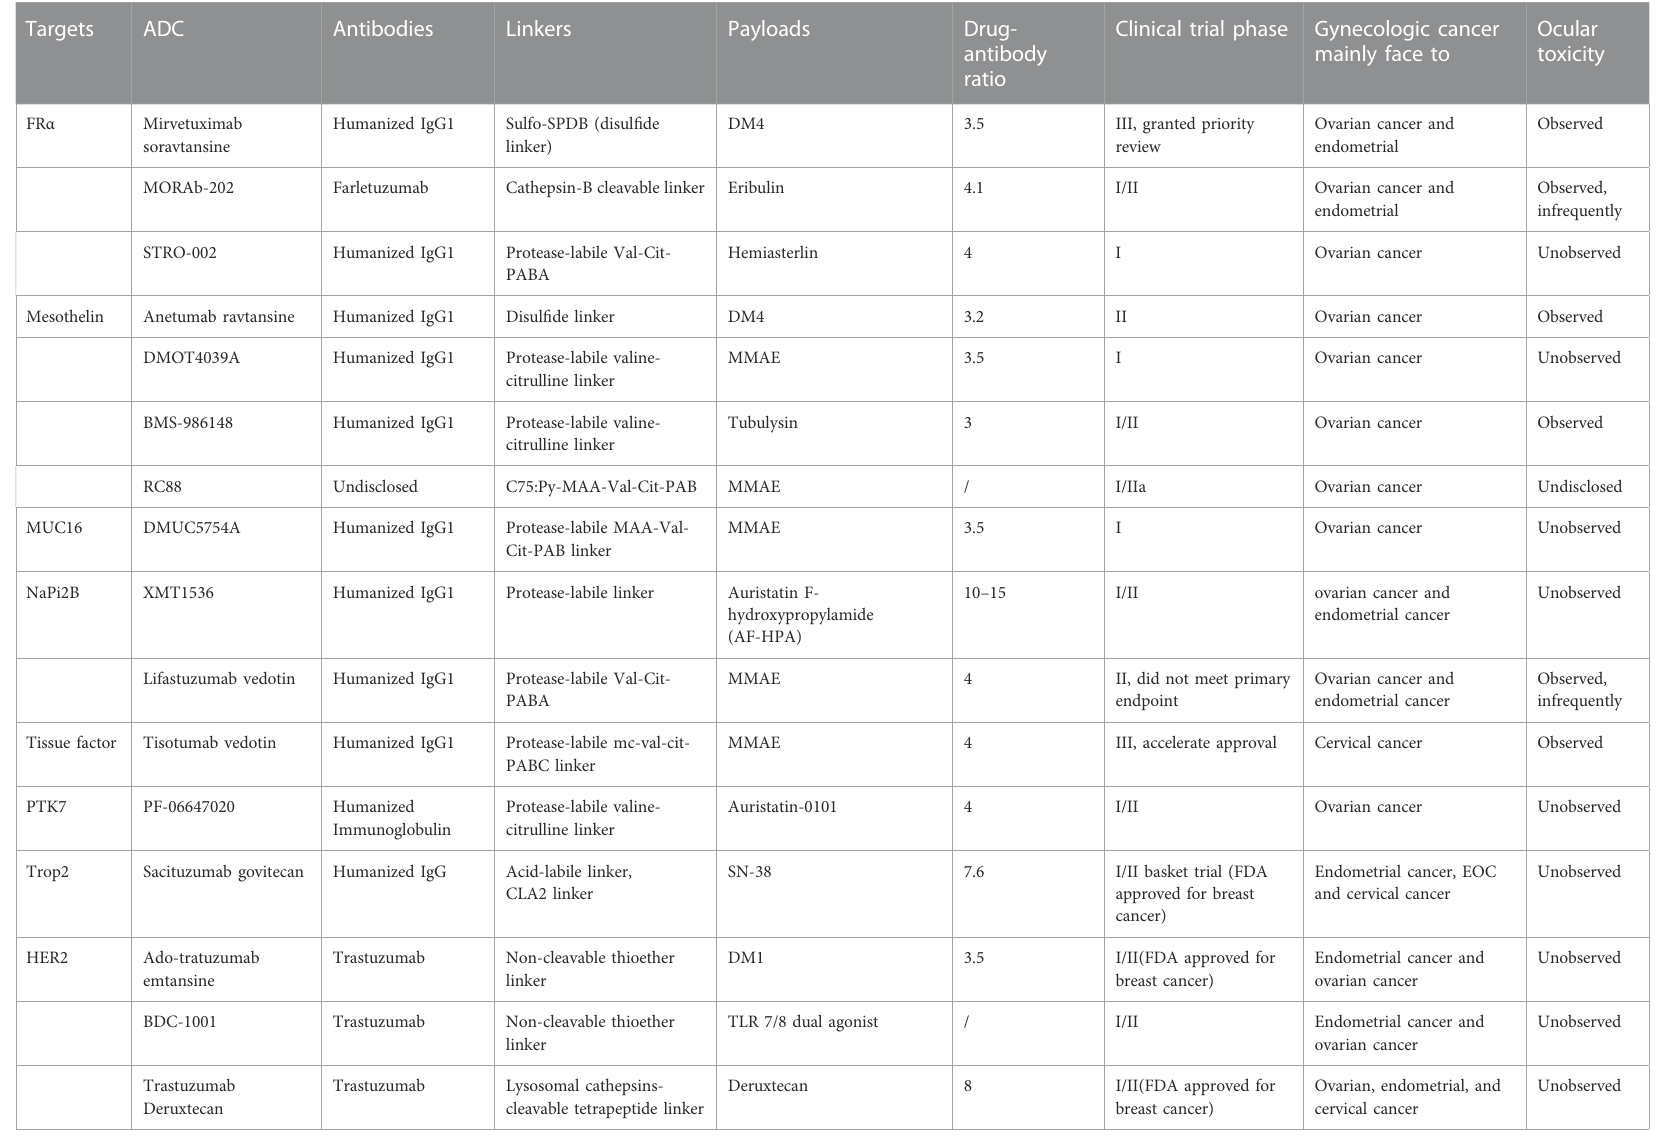
TABLE 3 ADCs in gynecologic oncology in clinical trial.